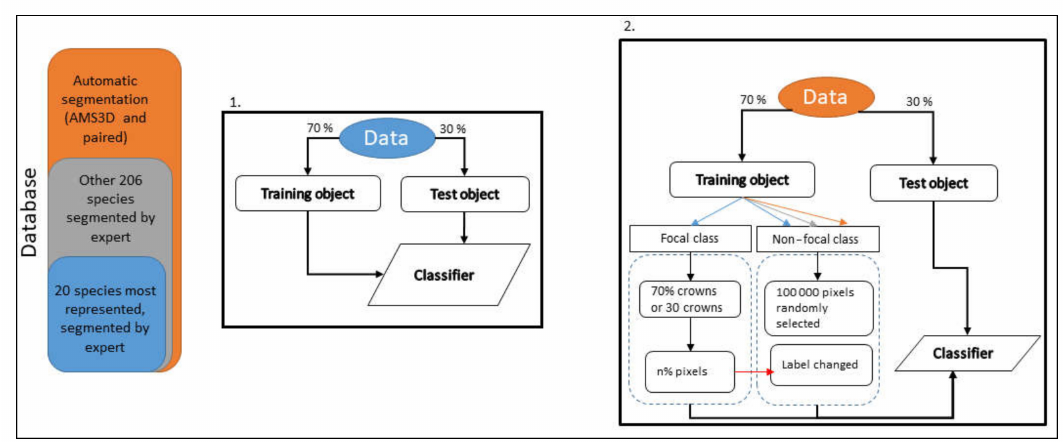
Figure 3. Nested datasets are used as illustrated in the leftmost chart. Flowchart 1 refers to Experiment 1. Flowchart 2 illustrates how classifiers were penalized by contamination of the non-focal class (Experiment